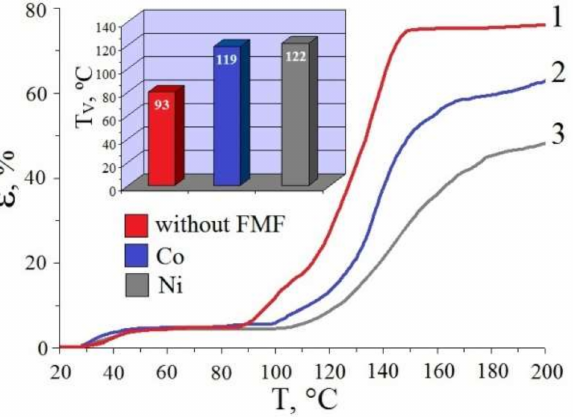
Figure 9. The effect of metal filler on temperature dependence of deformation ( ε ) and Vicat softening temperature ( T V ) of pHEMA-gr-PVP copolymers (HEMA:PVP = 80:20 mass parts, [FMF] = 10